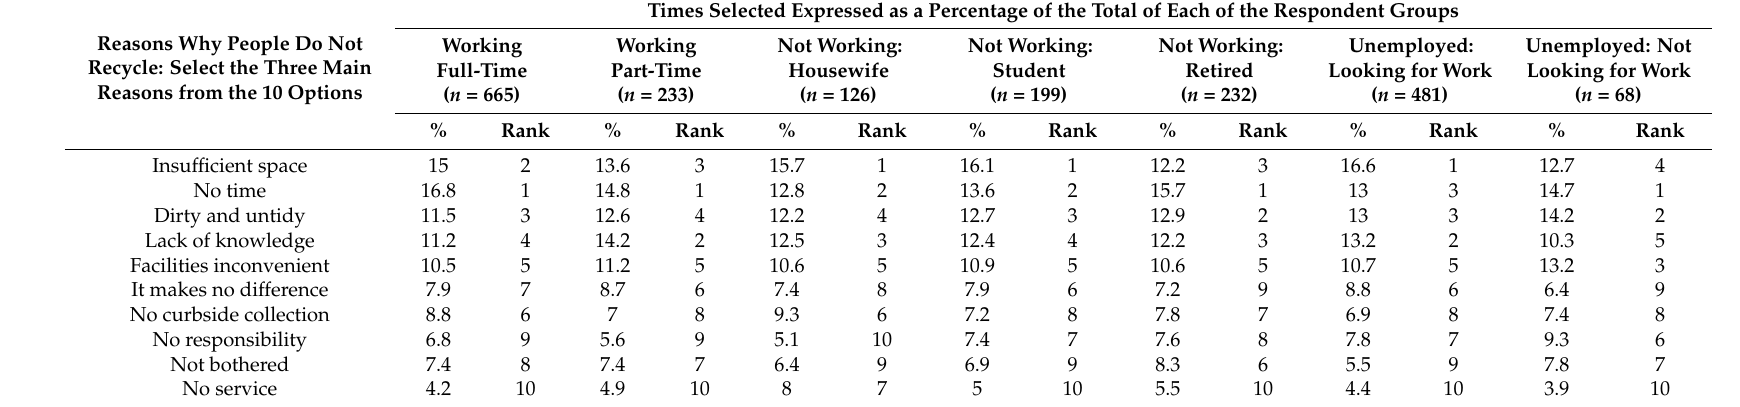
Table A5. Reasons why people do not recycle as enumerated per employment status group ( n = 2004).